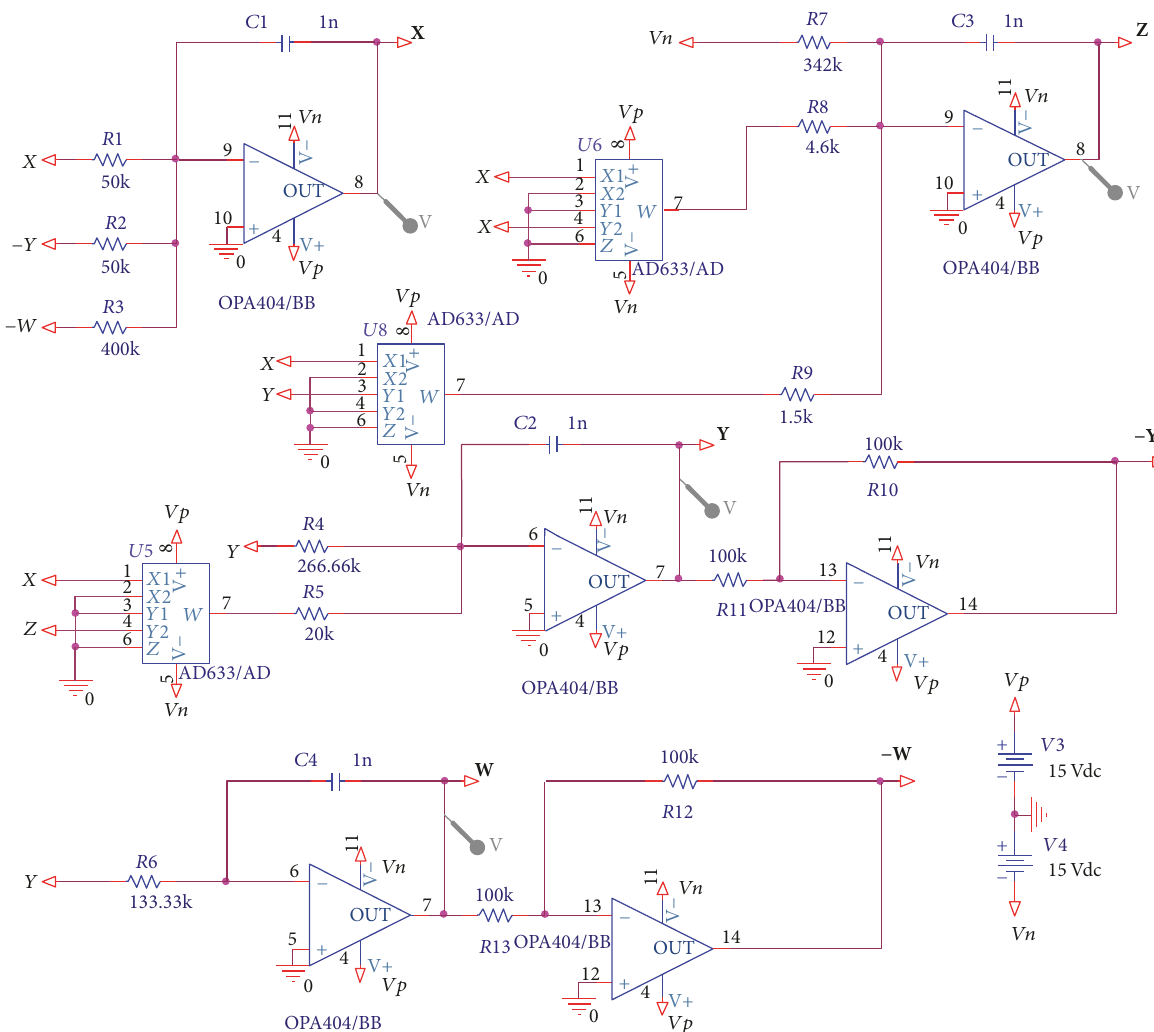
Figure 8: The electronic circuit schematic of the scaled hyperchaotic system